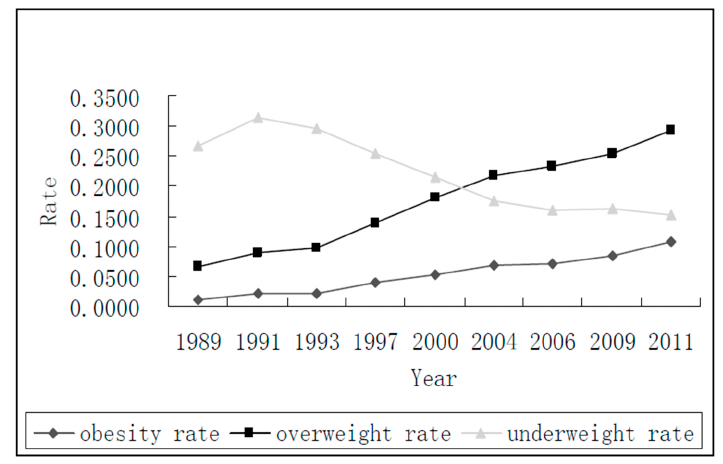
Figure 1. Obesity rate over time.